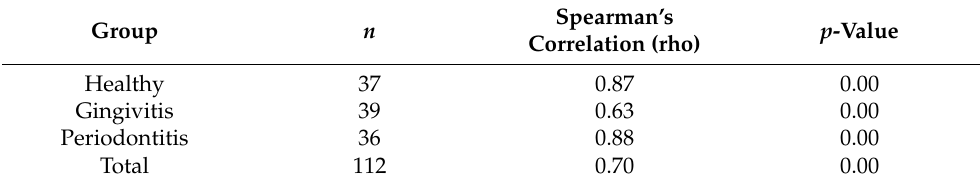
Table 4. Association between periodontal disease and cardiovascular risk, determined by